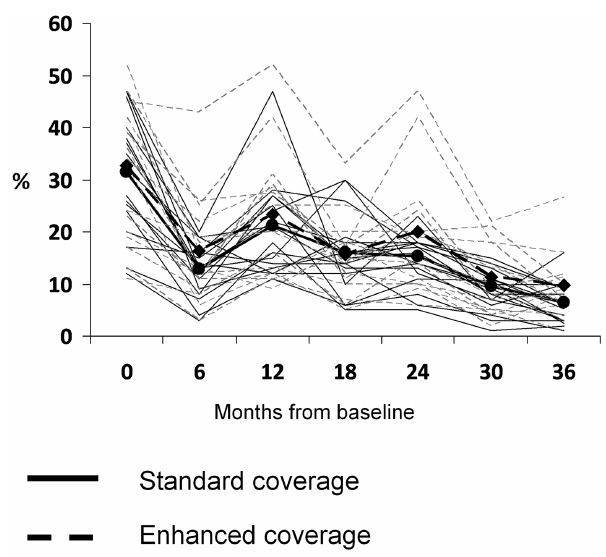
Figure 3. Prevalence of Follicular Trachoma (TF) over time by Coverage Arm.